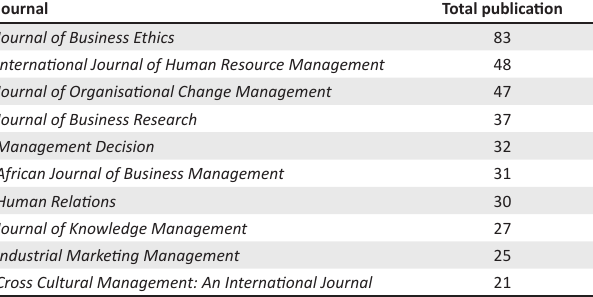
TABLE 5: Analysis of cluster information by country.